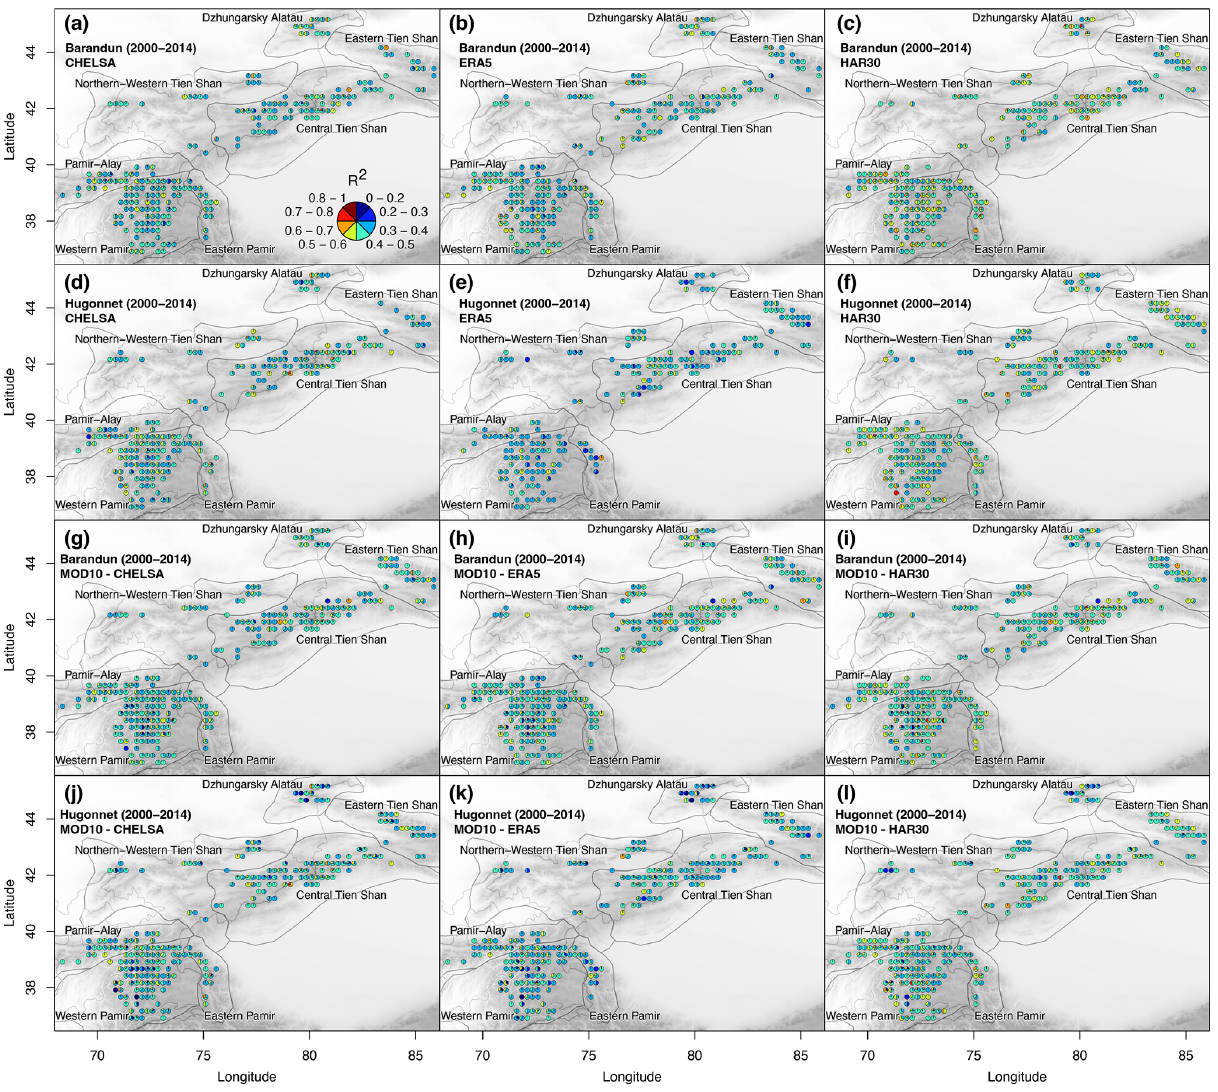
Figure A7. Coefficient of determination ( R 2 ) of temporal analysis between annual mass balance estimates from Barandun et al. (2021a) and Hugonnet et al. (2021) and two meteorological variables from the different reanalysis datasets as indicated in the figure legends. Upper two panels without and lower two panels including snow